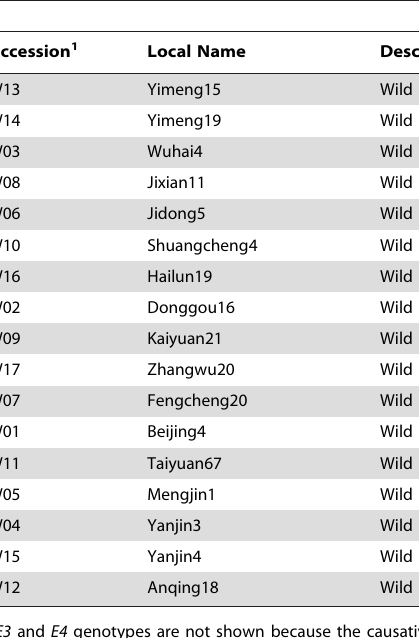
Table 3. Maturity and growth determinate genotypes for wild